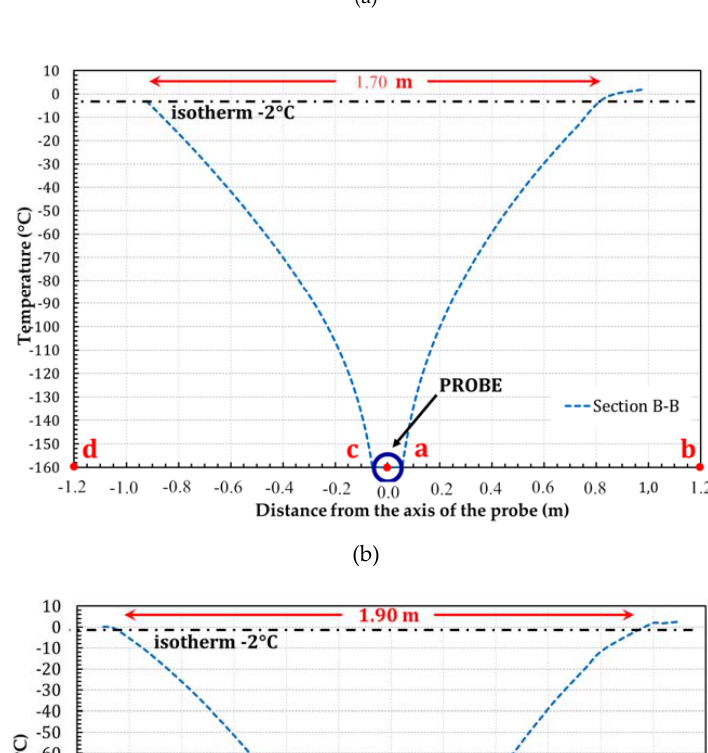
For the odd tunnel (left), further segments are considered, in order to verify the thickness of the ice wall at the end of Phase 1. Figure 15(a) shows the cut lines taken into account, while Figure 15(b) shows the temperature profiles calculated after 14 days for section C ‐ C.